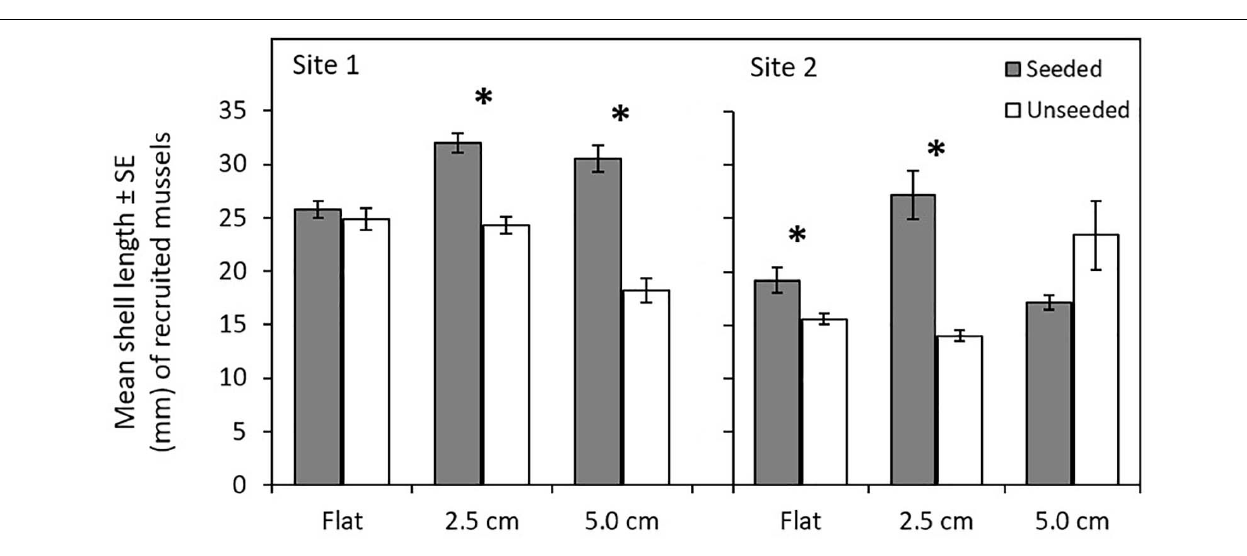
FIGURE 2 | Comparison of mean shell length (mm) ± standard error of mussels that recruited to flat and complex seeded and unseeded tiles at two sites in Plymouth, United Kingdom (NE Atlantic) at the end of 15-month experiments (April 2017–July 2018). Significant interactions among Site x Complexity x Seeding are shown by mussel seeding (seeded, unseeded tiles). Asterisks ( ∗ ) indicate significant differences between seeding treatments at P ≤